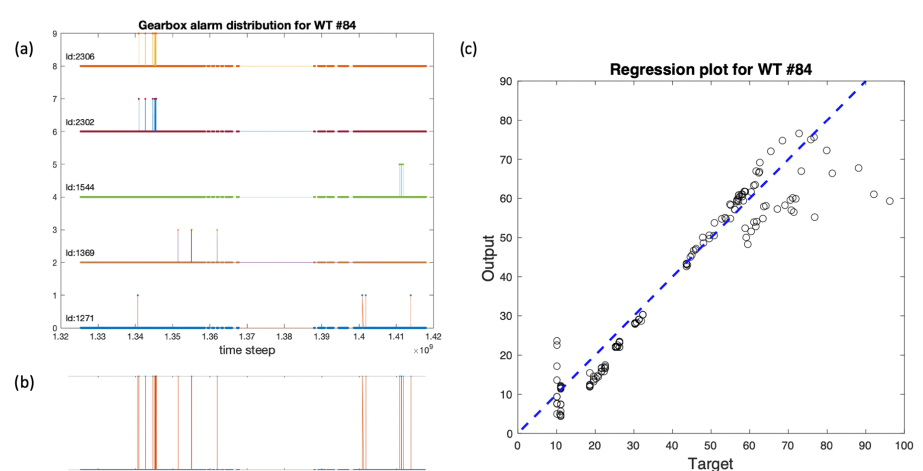
Figure 13. ( a ) Temporal distribution of the appearance of alarms in the gearbox subsystem to the WT#84. There are 5 different alarms (indicated by the identifiers of the Führlander). ( b ) Aggregation of the set of alarms represented in ( a ) in a single time frame. ( c ) Representation of the ( target , ˆ y ) pair generated by the model using the data corresponding to the intervals that go from 36 h to 12 h before each alarm is generated.